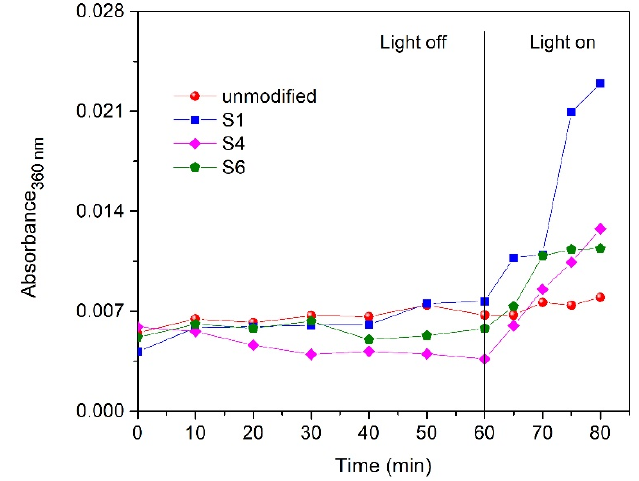
Figure 10. The absorbance of the MB solution, measured at 360 nm, for the unmodified and the modified (S1, S4 and S6) fabrics at different times of the adsorption and photocatalytic experiments.